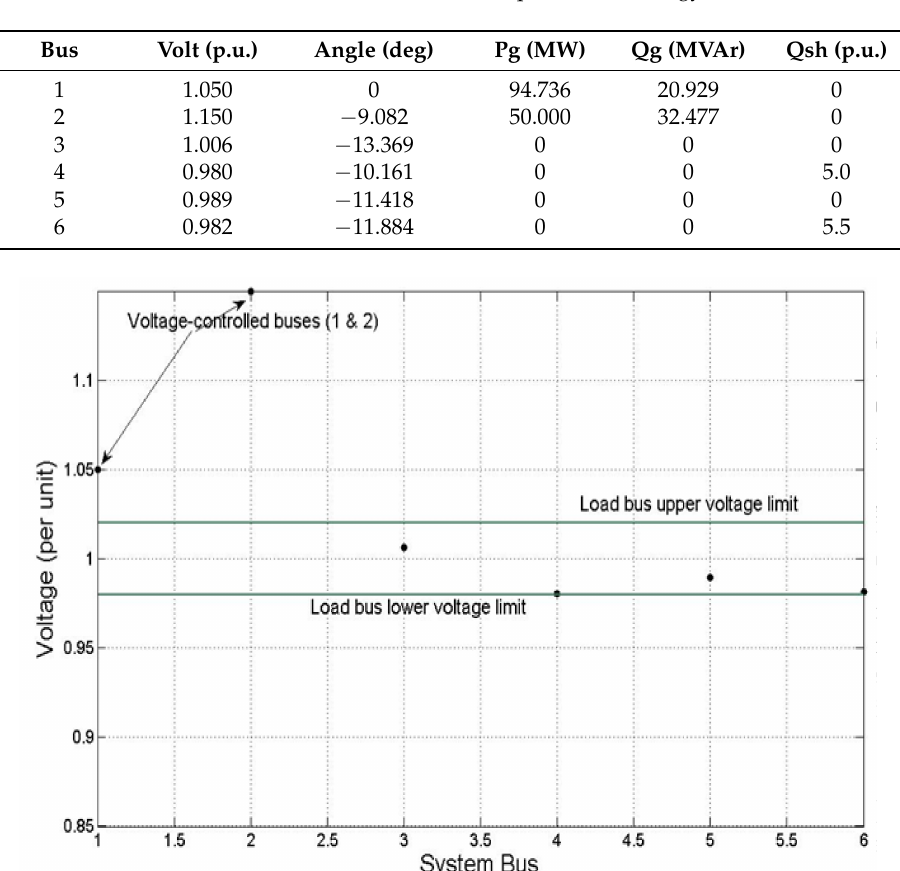
Table 2. Power flow results for equilibrium strategy.